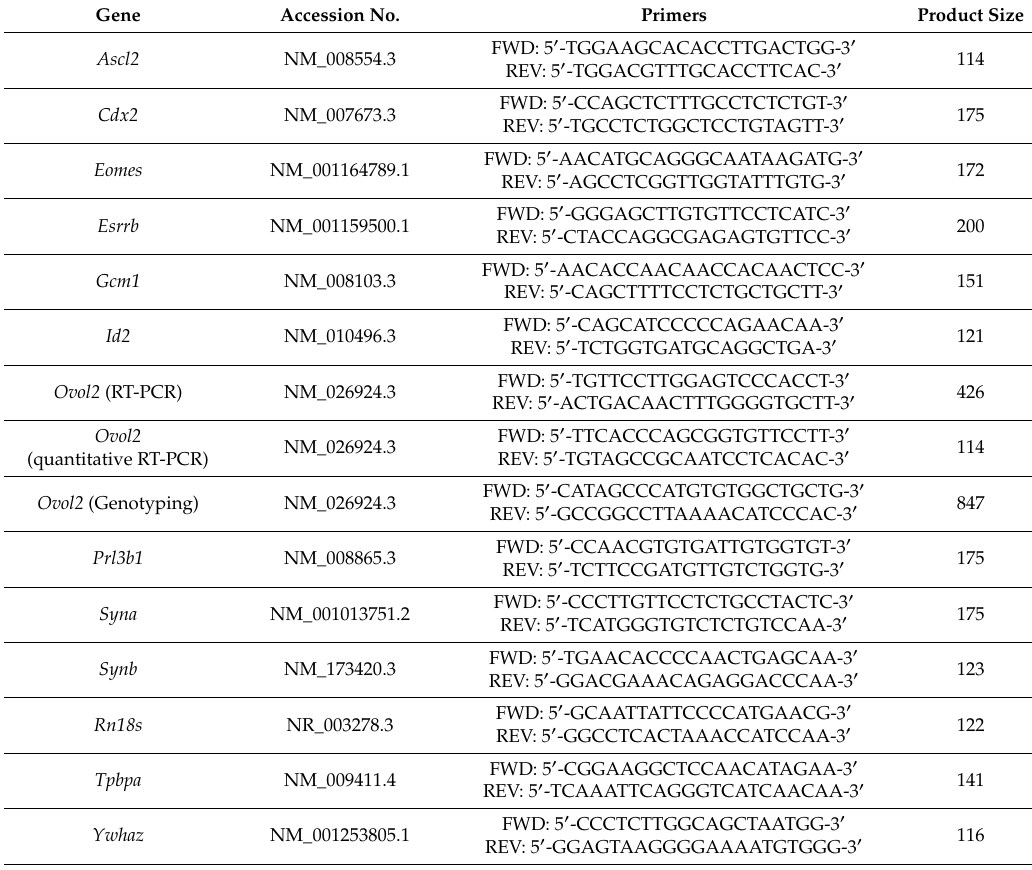
Table 1. Forward and reverse primers used for RT-PCR and quantitative RT-PCR